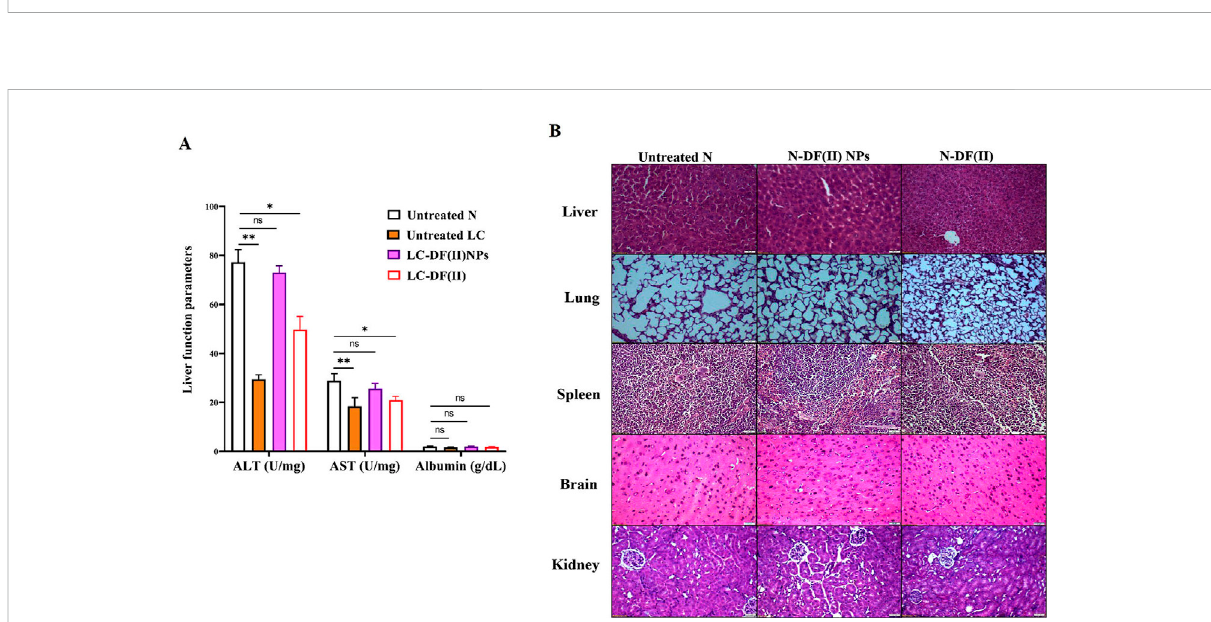
FIGURE 6 ImpactofDF(II)complexesonliverfunctionparametersaswellashistologicalassessmentoftheirtoxicityon tissuesofthetreatedNgroups (A) Liver function indexes (ALT, AST, and albumin) in healthy N group and the untreated and treated LC groups. Healthy N group was compared to the untreated and DF(II) complexes-treated LC groups, considering statistically signi fi cant at p ≤ 0.05*, ≤ 0.005**, and ≤ 0.001*** (B) H&E staining tissues of DF(II) NPs- and DF(II)-treated N groups compared to the untreated healthy N